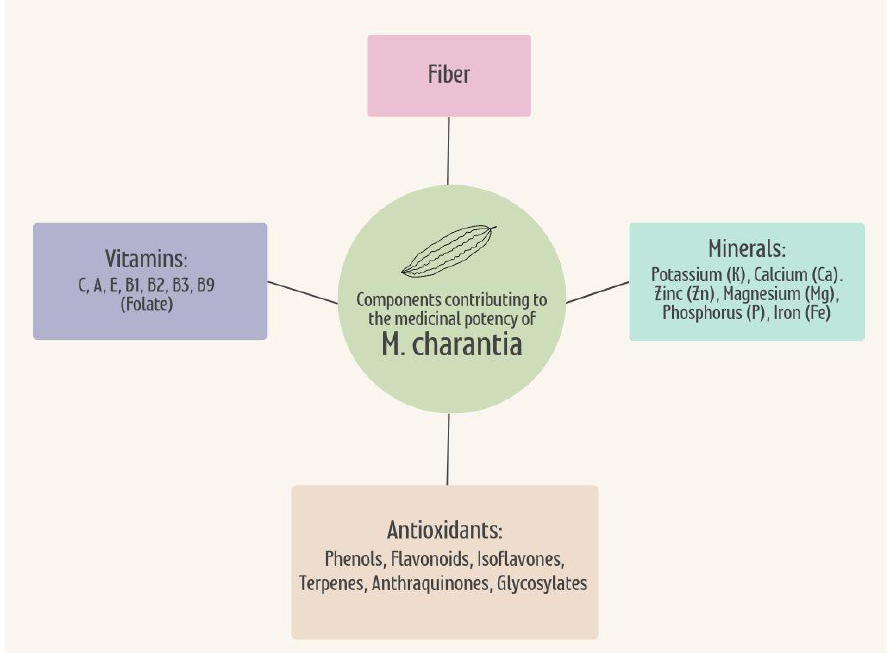
Figure 3. The combination of the nutritional properties within M. Charantia contributes to the overall therapeutic potential for the treatment and prevention of T2DM and AD. The vitamins, minerals, antioxidants, and fiber hold medicinal potency from the plant when consumed in the diet, as well as providing nutrients benefitting overall health. T2DM, type 2 diabetes mellitus; AD, Alzheimer’s disease.